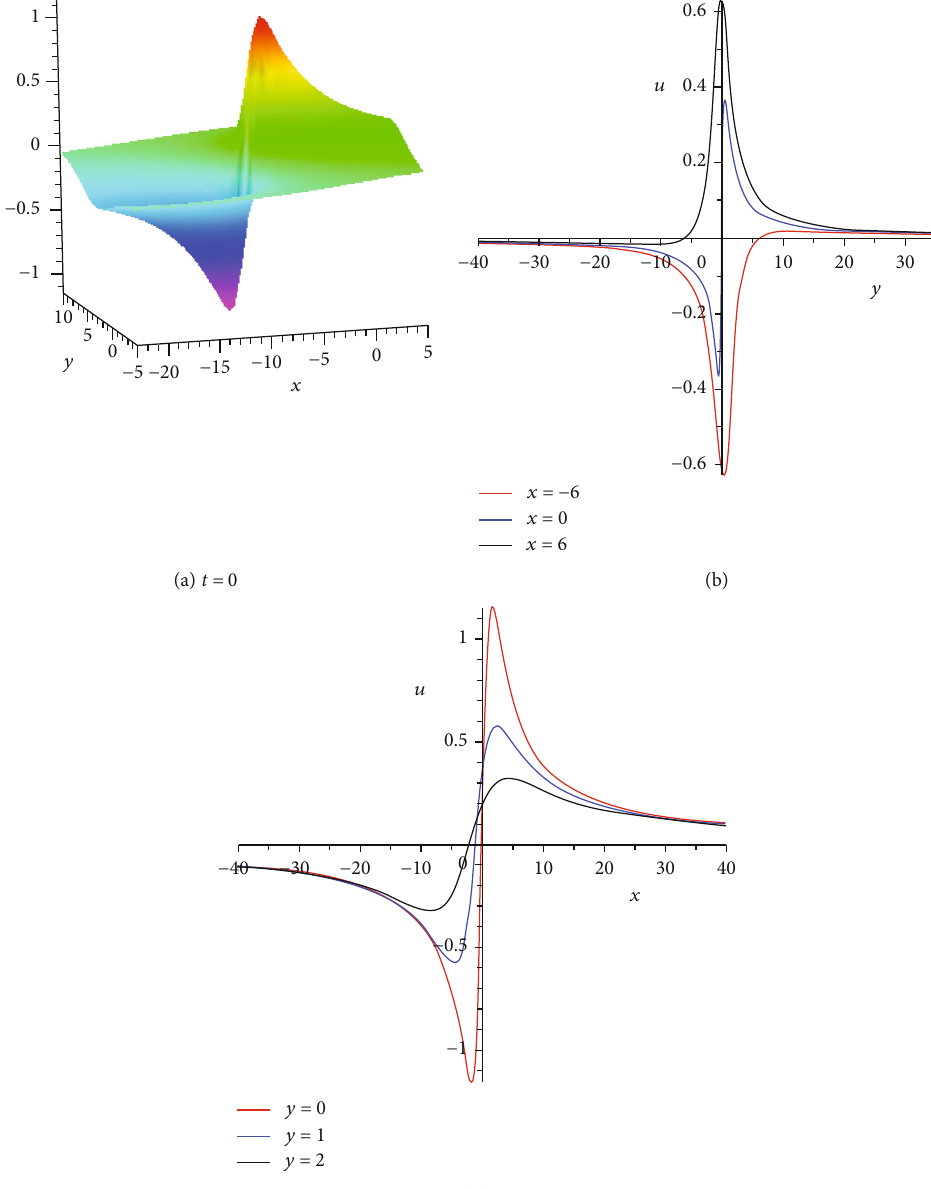
Figure 1: (Color online) The lump solution u to Equation (6) at α = 3 . (a) Contour plot. (b) x -curve. (c) y